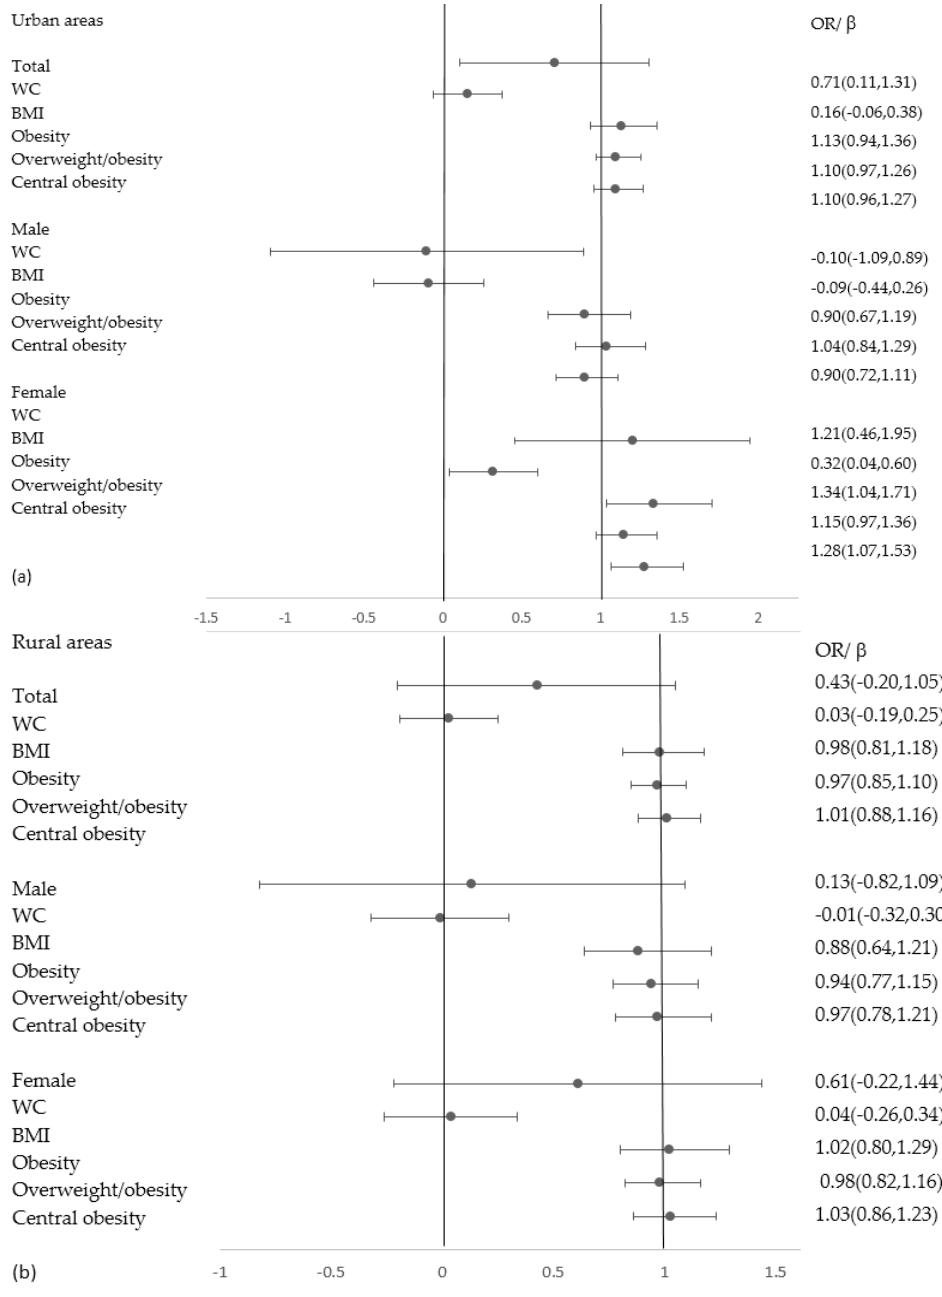
Figure 1. Subgroup analyses of the association between fetal famine exposure and obesity risk adjusting confounders. ( a ) Associations between fetal famine exposure and obesity risk in urban areas; ( b ) Associations between fetal famine exposure and obesity risk in rural areas.